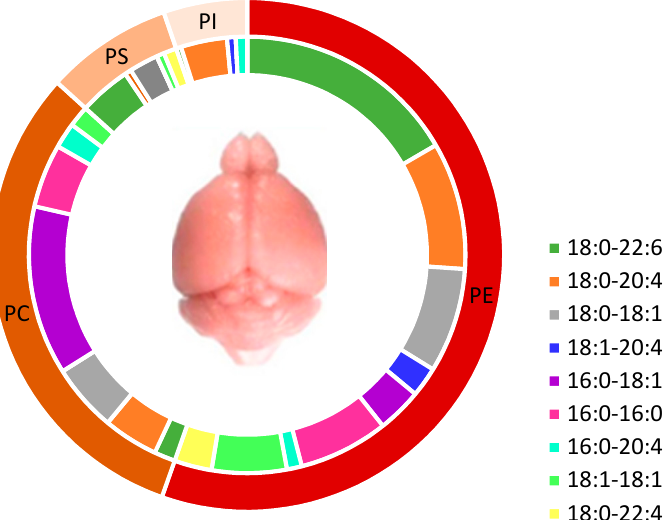
Figure 8. Major species of phospholipids in rats’ brains. Phospholipids content in fatty acids showed